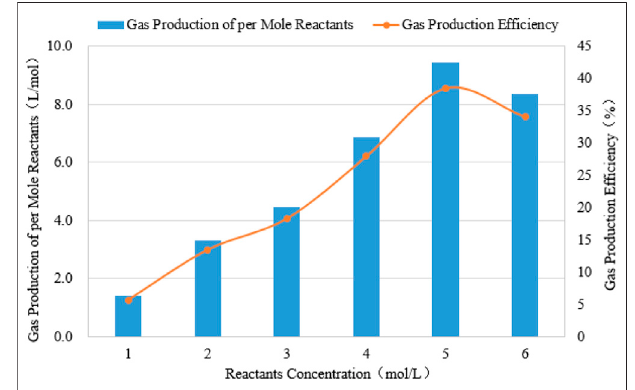
FIGURE 11 | Peak temperature (and peak time) vs. reactant concentration.